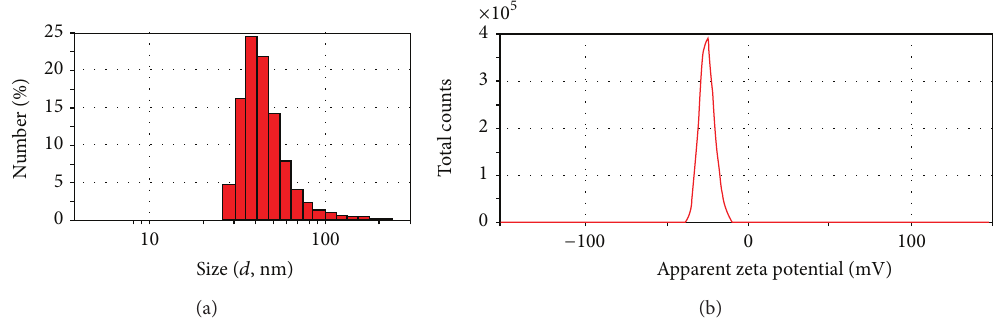
Figure 6: DLS analysis (a) and zeta potential (b) measurement of biosynthesized AgNPs. Synthesis conditions: silver nitrate concentration, 1mM; temperature, 45 ∘ C, extract pH, 9; extract concentration, 40g/L.